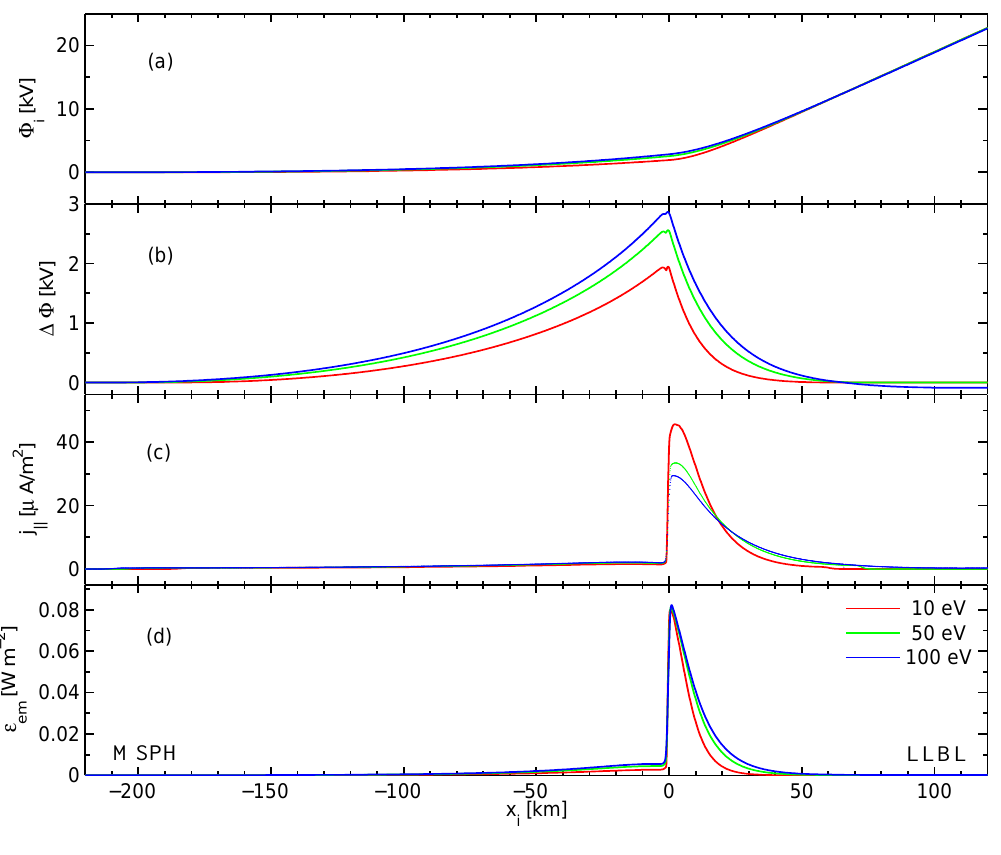
Fig. 8. Solutions of Eq. (1) and derived quantities obtained for various temperatures at the LLBL side of the TD. Magnetospheric and ionospheric parameters are given in Tables 1 and 2; same panel format as in Fig.